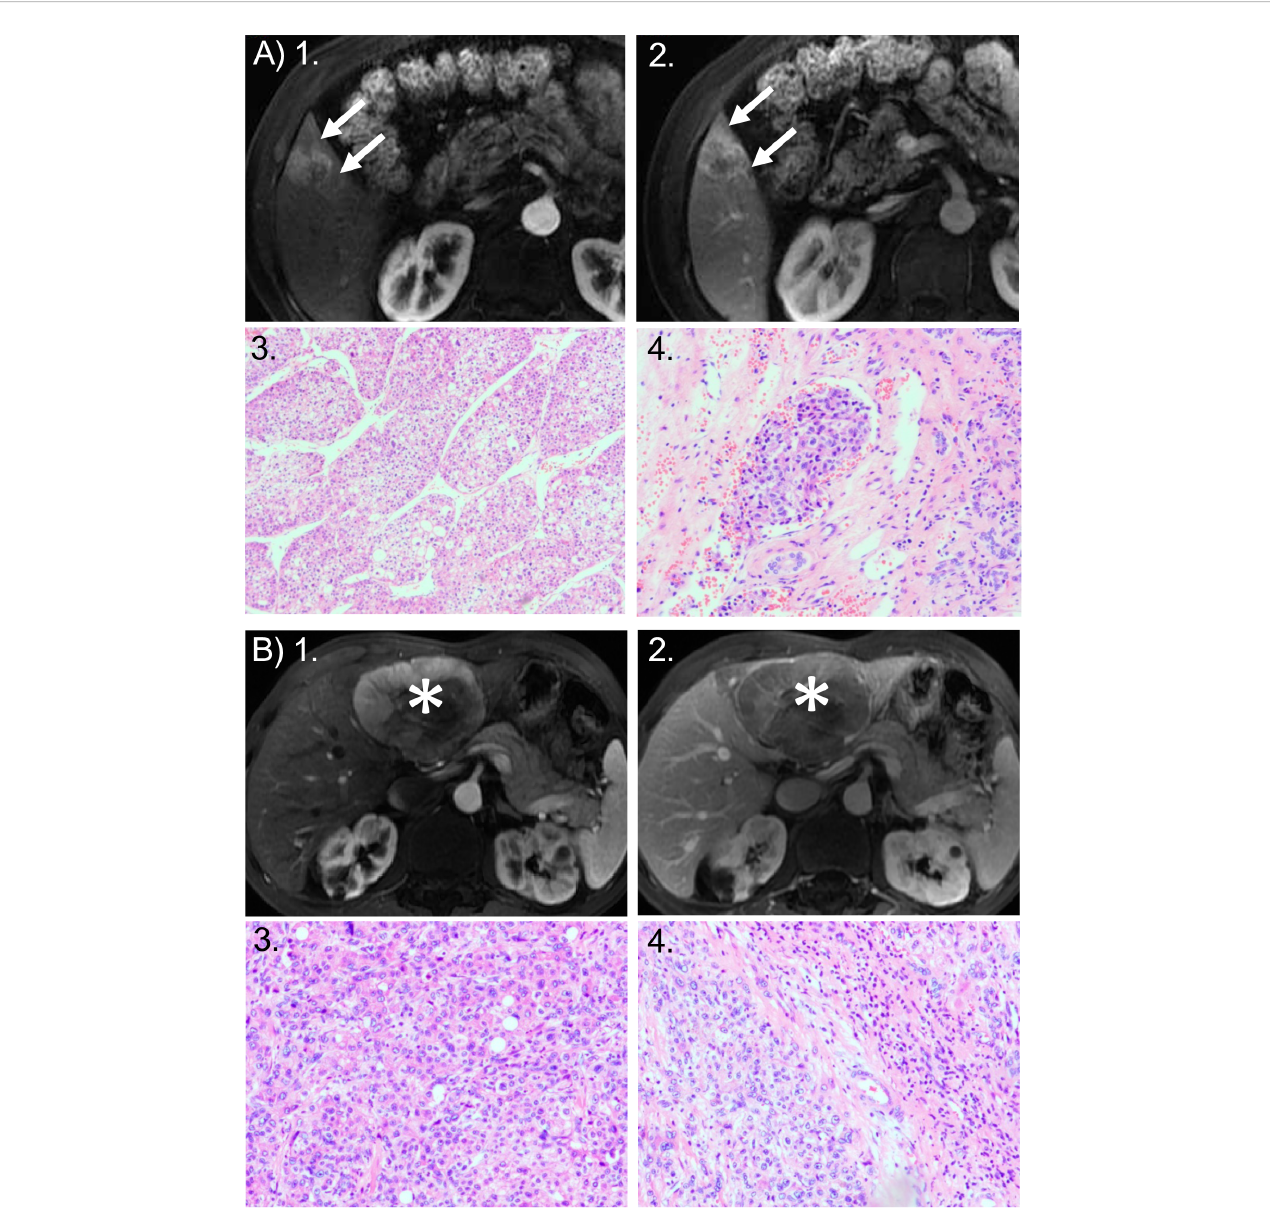
FIGURE 2 Representative cases of MTM and non-MTM subtype of HCC. (A) MTM HCC: 49-year-old woman with a 2.8-cm HCC tumor in hepatic segment V. HCC was the macrotrabecular-massive (MTM) subtype and showed microvascular invasion (MVI). Axial MRI scans in the: (1) arterial phase and (2) portal venous phase show the tumor with corona enhancement: a periobservational region of irregular bright enhancement ( arrow ). Photomicrographs show the predominant MTM appearance: (3) the trabeculae are more than 6 cells thick, and they account for more than 50% of the entire tumor area (hematoxylin-eosin stain; original magni fi cation, ×50); and (4) the presence of clusters of tumor cells covered by vascular endothelial cells in the peritumoral liver (hematoxylin-eosin stain; original magni fi cation, ×100). Recurrence occurred 11 months after surgical resection. (B) non-MTM HCC: 67- year-old man with 8.1-cm non-MTM HCC. Axial arterial phase MRIs in the: (1) arterial phase and (2) portal venous phase show heterogeneous hyperenhancement in the mass (asterisks) with a clear border, but no corona enhancement. Photomicrographs show: (3) a microtrabecular pattern; and (4) the absence of MVI. Both images are hematoxylin-eosin stained sections; original magni fi cation, ×100. Recurrence did not occur within 2 years after surgical